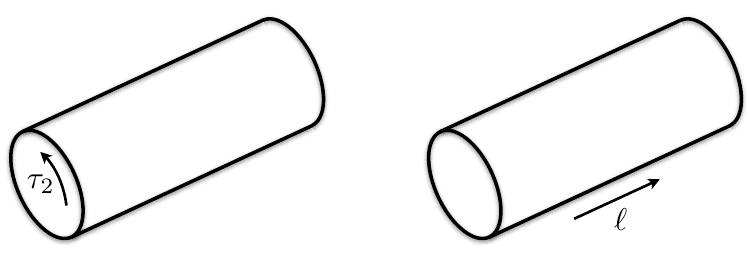
Figure 4 . Left: loop-diagram for open string; right: tree-diagram for closed